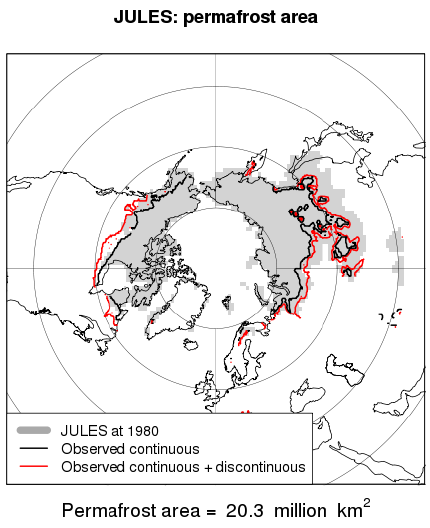
Figure 2. JULES simulated permafrost extent is shaded grey. The boundaries of the observed continuous and discontinuous per- mafrost are superimposed in black and